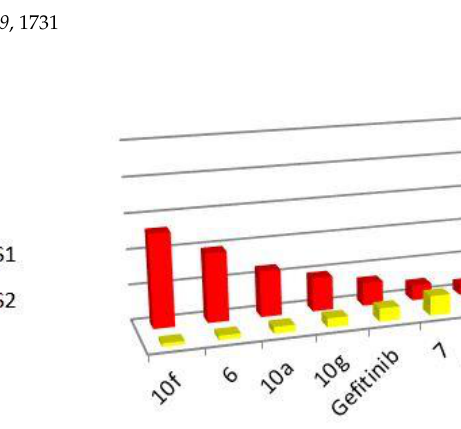
Figure 4. Selectivity of title compounds toward the two cell lines MCF-7 and MDA-MBA-231. Compounds are arranged according to their selectivity order. Increasing yellow color (S1) indicates increasing selectivity to MDA-MBA-231, while increasing red color (S2) indicates increasing selectivity to MCF-7.